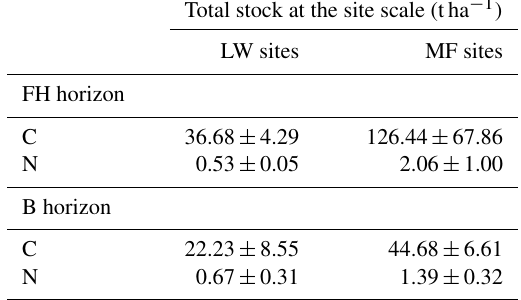
Table 6. Carbon and nitrogen stocks contained in FH and B hori- zons. Values are given as means ± standard